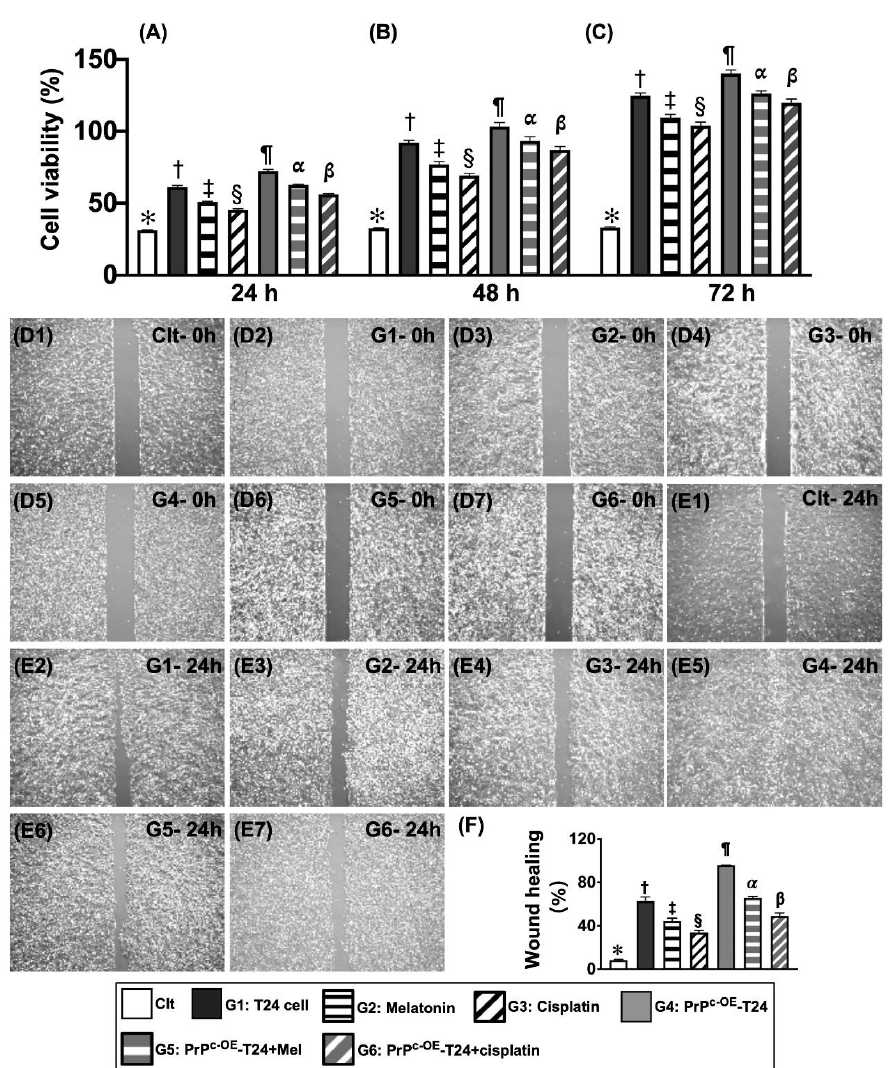
Figure 2. The cell viability and wound healing rate in different situations. ( A ) Analysis of the cell survival rate by 24 h (i.e., cell viability), * vs. different symbols (†, ‡, §, ¶, α , and β ), p < 0.0001. ( B ) Analysis of the cell survival rate by 48 h (i.e., cell viability), * vs. different symbols (†, ‡, §, ¶, α , and β ), p < 0.0001. ( C ) Analytical result of the cell survival rate by 72 h (i.e., cell viability), * vs. different symbols (†, ‡, §, ¶, α , and β ), p < 0.0001. ( D1 – D4 , E1 – E7 ) The microscopic findings (40 × ) at 0 h (i.e., ( D1 – D7 )) and 24 h (i.e., ( E1 – E7 )) for illustrating the “wound healing” process (cell amount: 5.0 × 10 4 /well) between the seven groups. ( F ) Analysis of percentage of wound healing at 24 h, * vs. different symbols (†, ‡, §, ¶, α , and β ), p < 0.0001. Symbols: (*, †, ‡, §, ¶, α , and β ) or letters ( E1 – E7 ) indicate significance for each other (at 0.05 level). All statistical analyses were conducted by one-way ANOVA, followed by Bonferroni multiple comparison post hoc test (n = 6 for each group). The formula for the calculation of the wound healing process (%) = cell migrated area at 24 h/the original migrated area at 0 h. PrP C = cellular prion protein. Control (Clt) = V-HUC-1; G1 = T24 only; G2 = melatonin (Mel); G3 = cisplatin; G4 = PrP C overexpression in T24 cells (i.e., PrP C-OE -T24); G5 = PrP C-OE -T24 cells + Mel (100 µ M treated for 24 h); G6 = PrP C-OE -T24 cells + cisplatin (6.0 µ M treated for 24